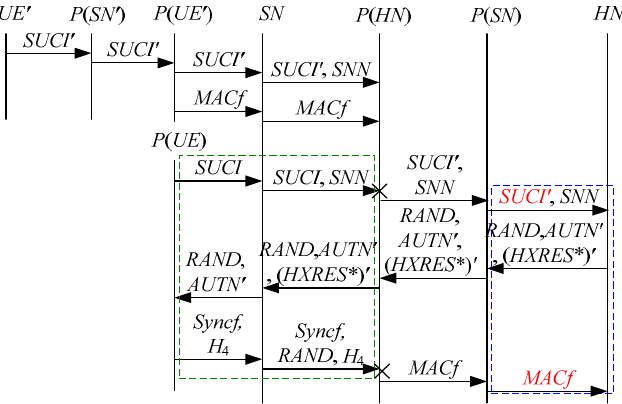
Figure 19. The eighteenth attack scenario of the 5G AKA protocol.